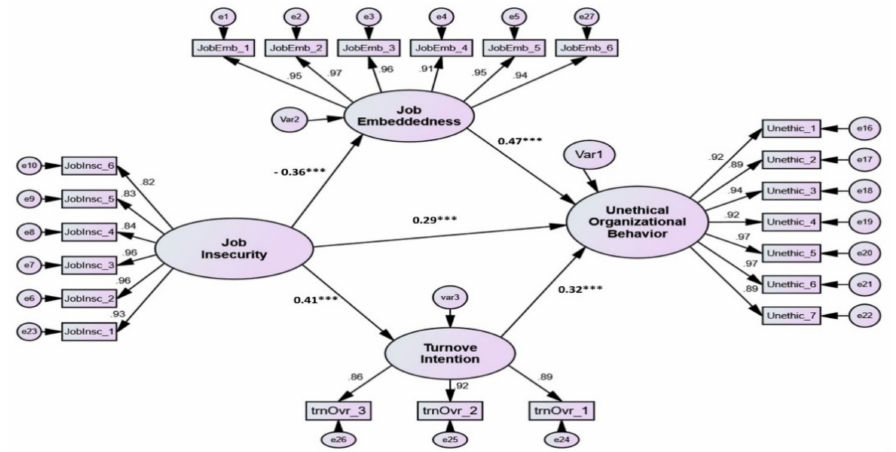
Figure 2. Research model (developed by authors). *** Significant level is less than